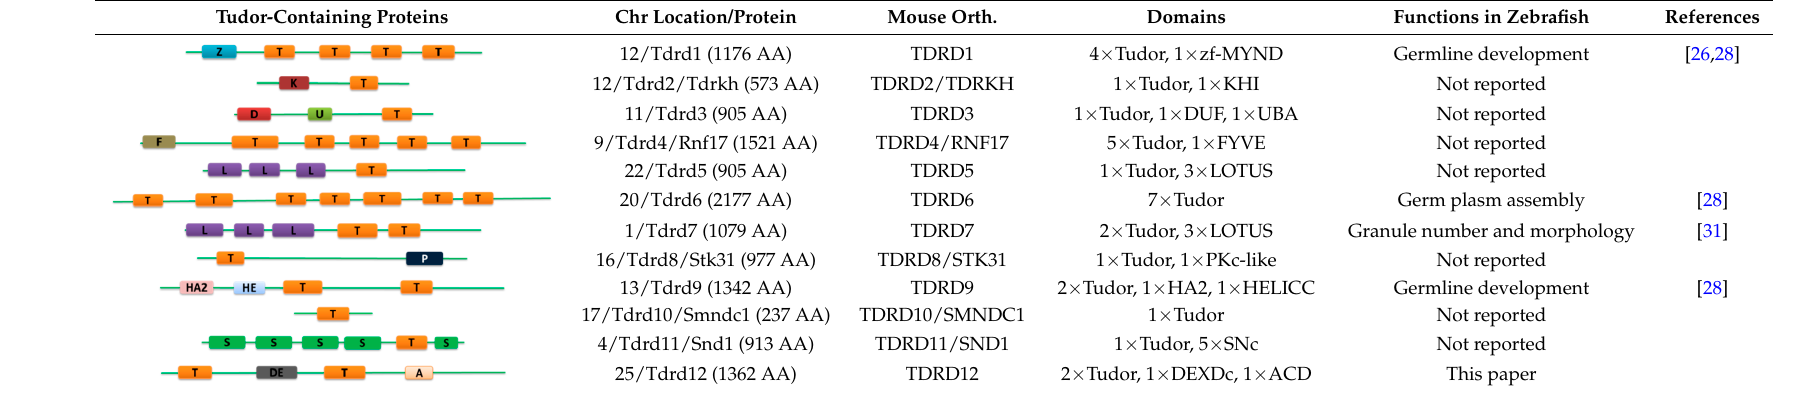
Table 2. Identification and classification of Tdrd family members in zebrafish. Table 2. Identi fi cation and classi fi cation of Tdrd family members in zebrafish. Table 2. Identi fi cation and classi fi cation of Tdrd family members in zebrafish. Table 2. Identi fi cation and classi fi cation of Tdrd family members in zebrafish. Table 2. Identi fi cation and classi fi cation of Tdrd family members in zebrafish. Table 2. Identi fi cation and classi fi cation of Tdrd family members in zebrafish. Table 2. Identi fi cation and classi fi cation of Tdrd family members in zebrafish. Table 2. Identi fi cation and classi fi cation of Tdrd family members in zebrafish. Table 2. Identi fi cation and classi fi cation of Tdrd family members in zebrafish. Table 2. Identi fi cation and classi fi cation of Tdrd family members in zebrafish. Table 2. Identi fi cation and classi fi cation of Tdrd family members in zebrafish. Table 2. Identi fi cation and classi fi cation of Tdrd family members in zebrafish. Table 2. Identi fi cation and classi fi cation of Tdrd family members in zebrafish. Tudor-Containing Proteins Chr Tudor-Containing Proteins Chr Location/Protein Tudor-Containing Proteins Tudor-Containing Proteins Chr Location/Protein Mouse Orth. Tudor-Containing Proteins Tudor-Containing Proteins Mouse Orth. Tudor-Containing Proteins Tudor-Containing Proteins Chr Location/Protein